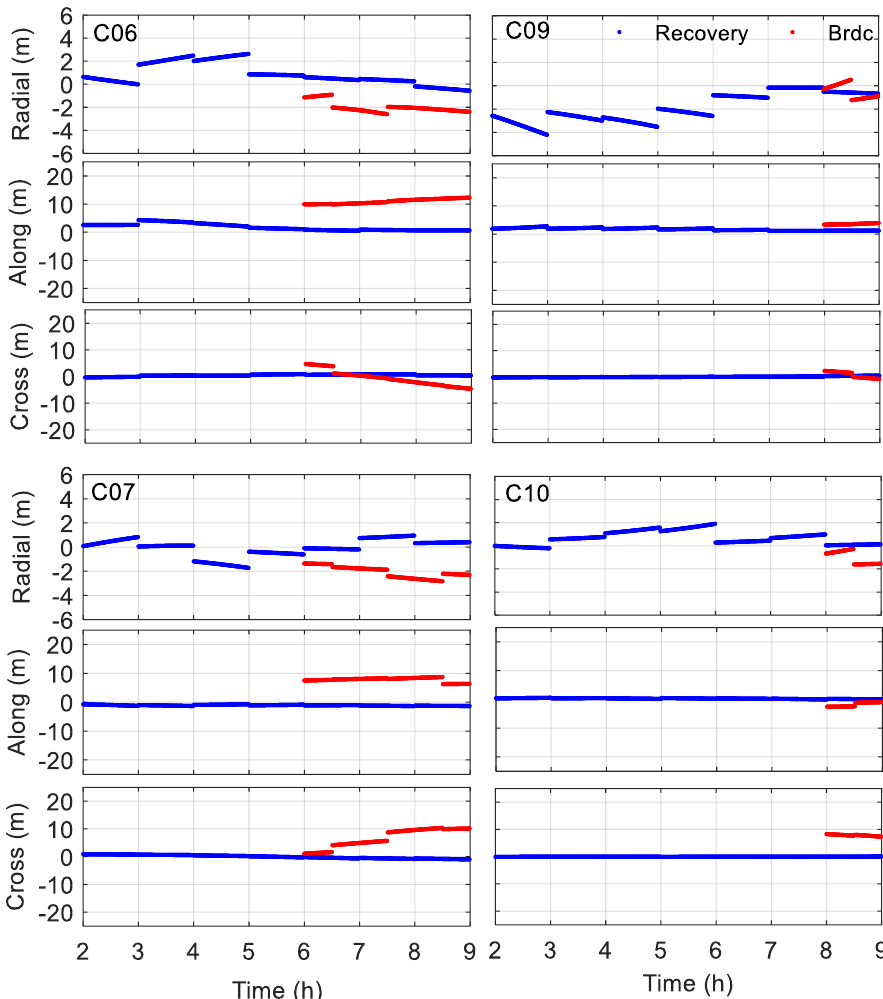
Figure 7. Errors of the orbit recovery results and healthy broadcast ephemerides of the studied IGSO satellites. Top left: C06 on 24 September, top right: C09 on 21 September, bottom left: C07 on 16 October, bottom right: C10 on 27 October.